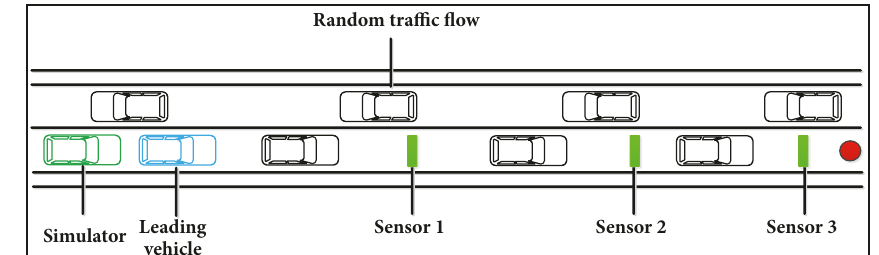
Figure 3: Car-following scenario.